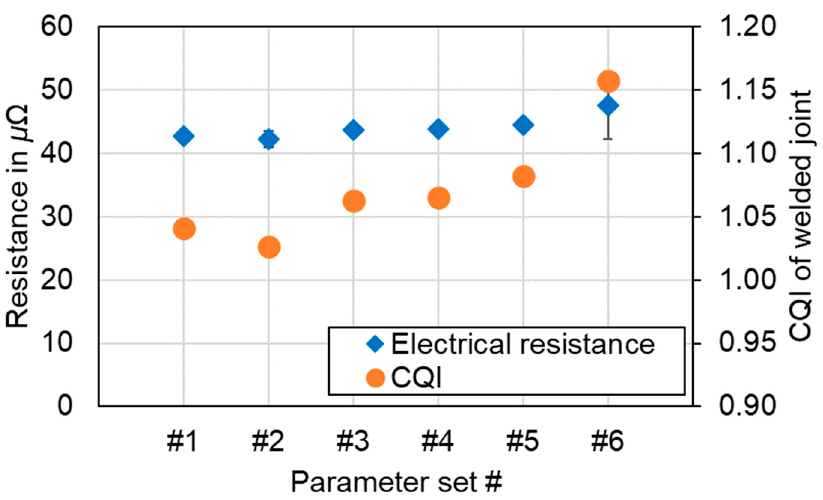
Figure 25. Electrical contact resistance and CQI of the specimen welded with parameter sets #1–#6 (see Table 5).